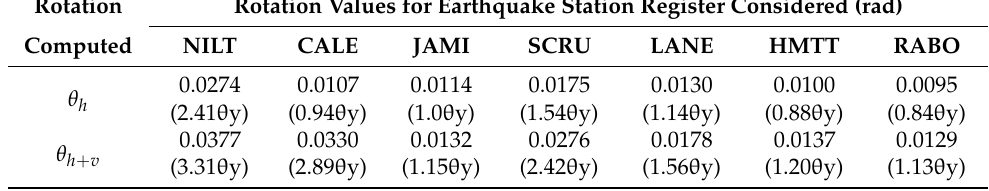
Table 3. Rotations generated by horizontal earthquake components and by horizontal and vertical earthquake components acting together (10-story